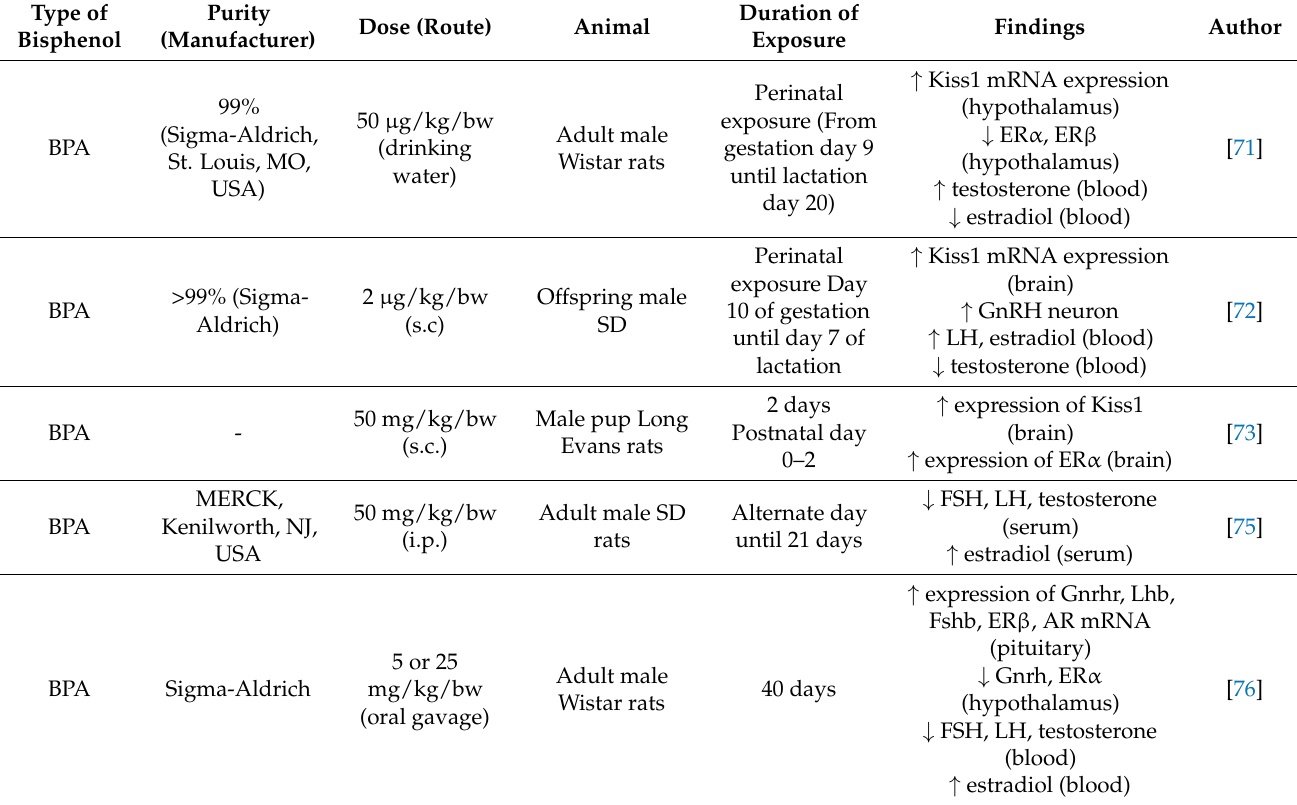
Table 1. The effects of BPA and its analogues on the hypothalamus-pituitary-gonadal axis in male reproductive system. Type of